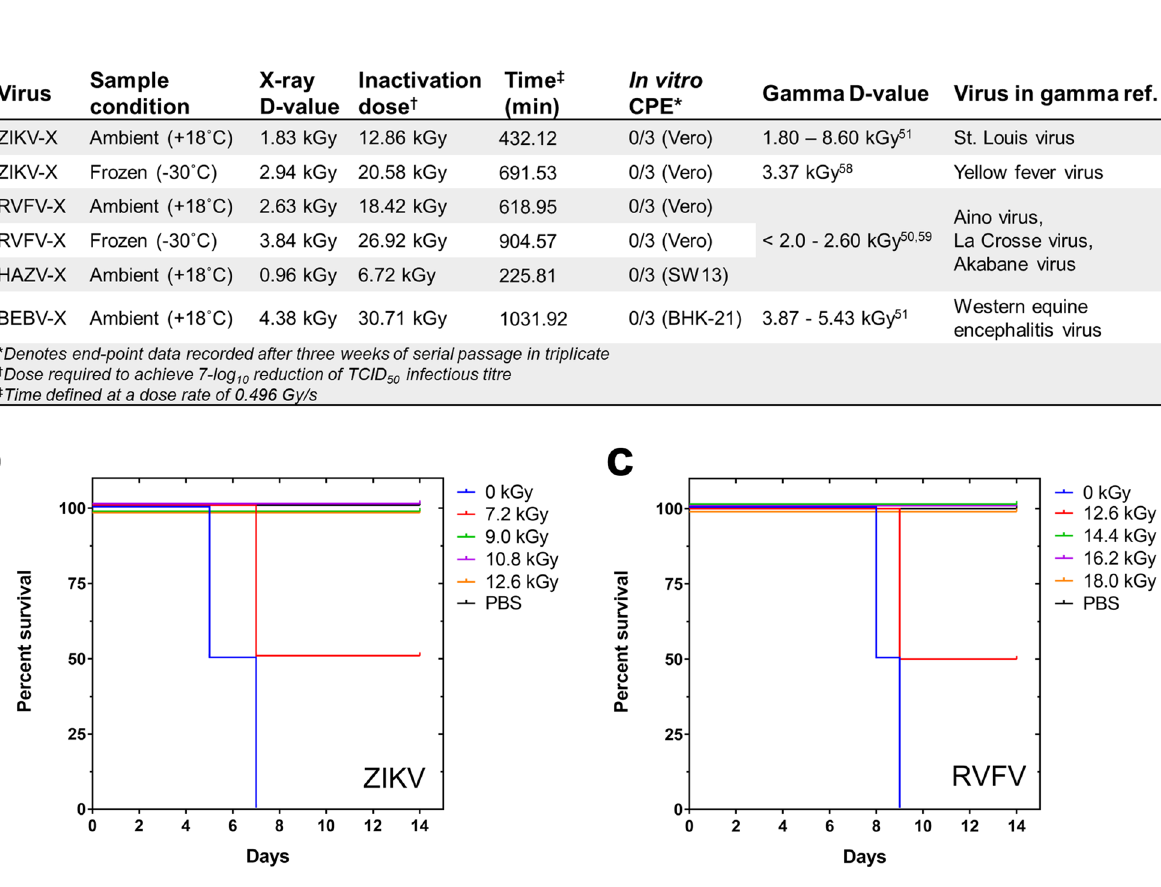
Figure 2. Inactivation of viral pathogens using X-rays. (a) X-ray D-values showing the dose required to inactivate 1-log 10 of virus at 220 keV, 17.5 mA with 0.2 mm Al filtration. In vitro CPE was not observed in an infection-sensitive cell substrate after treatment with 1 mL of virus and following 3 passages at